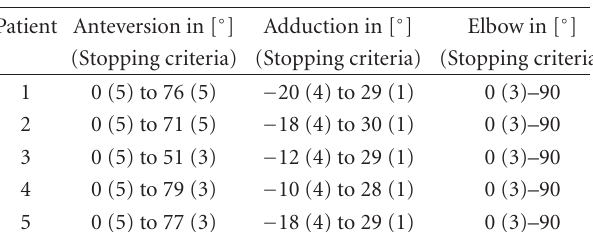
Table 6: Results of the